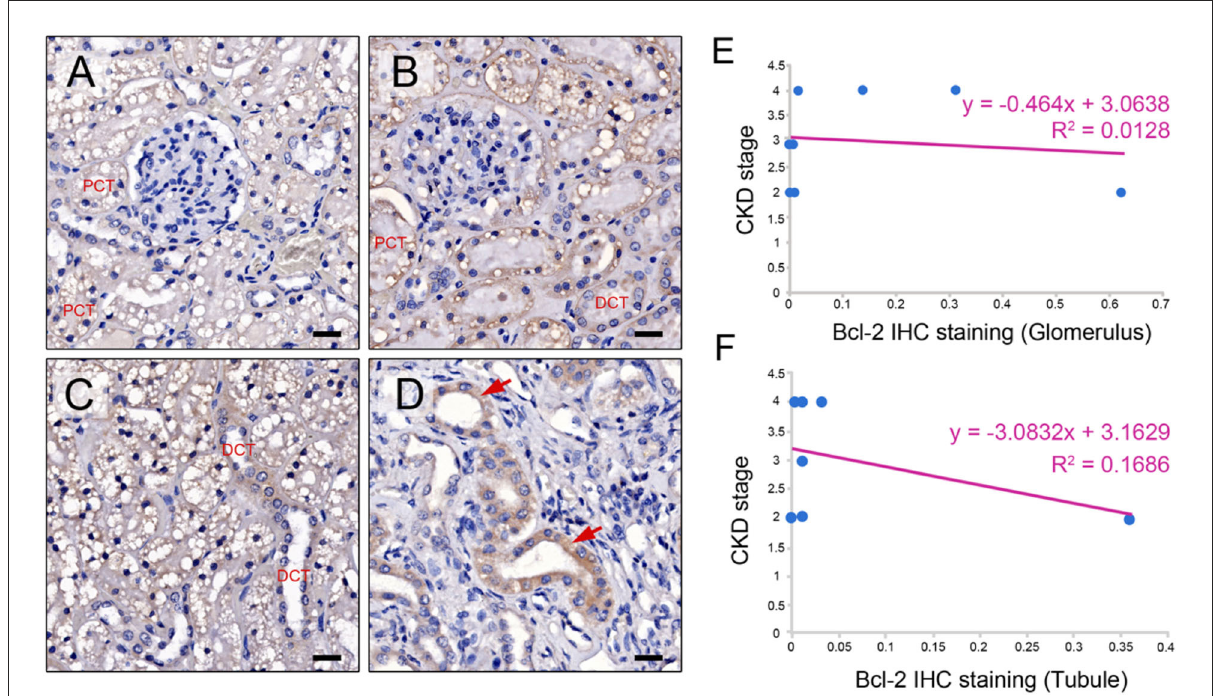
FIGURE2 Bcl-2 protein expression. Representative IHC images illustrating the range of staining intensity for Bcl-2 in the Bowman’s capsule, the proximal convoluted tubule (PCT), distal convoluted tubule (DCT) (A, B) , the distal convoluted tubule (DCT) (C) , and the collecting duct in the cats with CKD (red arrows) (D) . Original magnification 400 × . Scale bar = 20 µ m. CKD stage and Bcl-2 staining are correlated at the glomerulus and (E) and tubule (F)